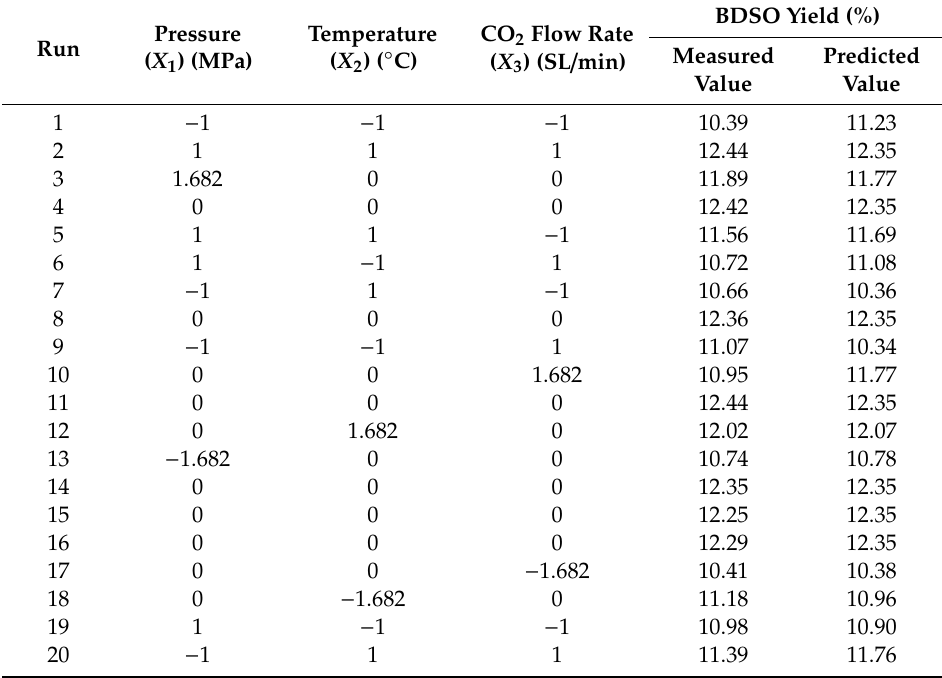
Table 1. Central composite design and results for the yield of B. dasystachya seed oil (BDSO).